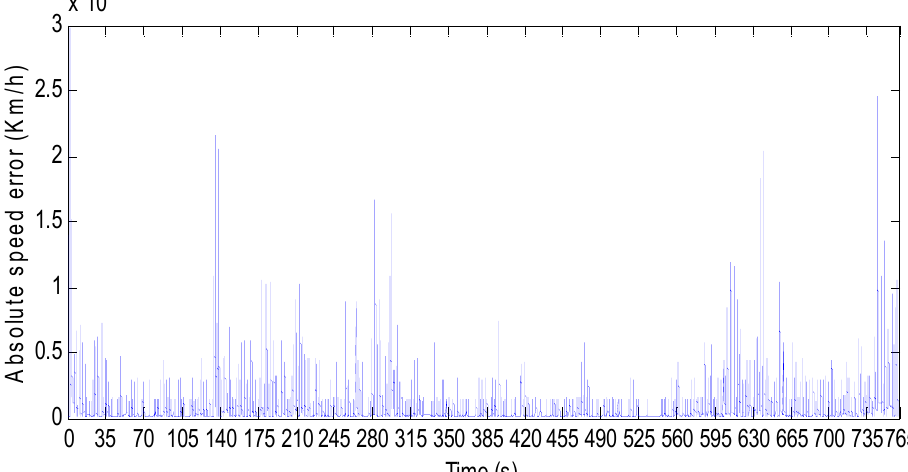
Figure 31. BEV speed absolute error for HWEFT driving cycle.